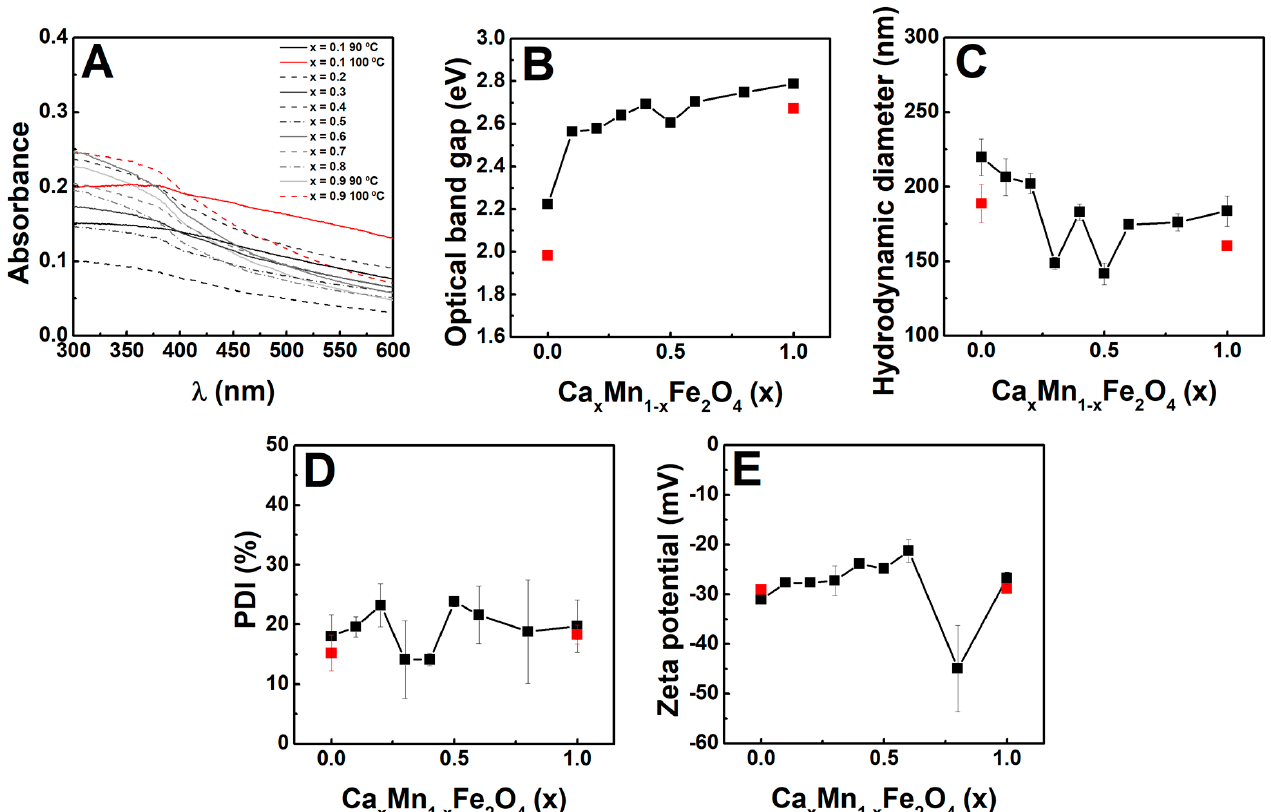
Figure 5. ( A ) UV-vis absorption spectra of the synthesized nanoparticles at 0.01 mg/mL and ( B ) dependence of the optical band gap on the Ca/Mn content for the particles synthesized at 90 °C (black squares) and 100 °C (red squares). The dependence of ( C ) hydrodynamic diameter, ( D ) polydispersity index (PDI), and ( E ) zeta potential on the particle type at 0.01 mg/mL is also included.